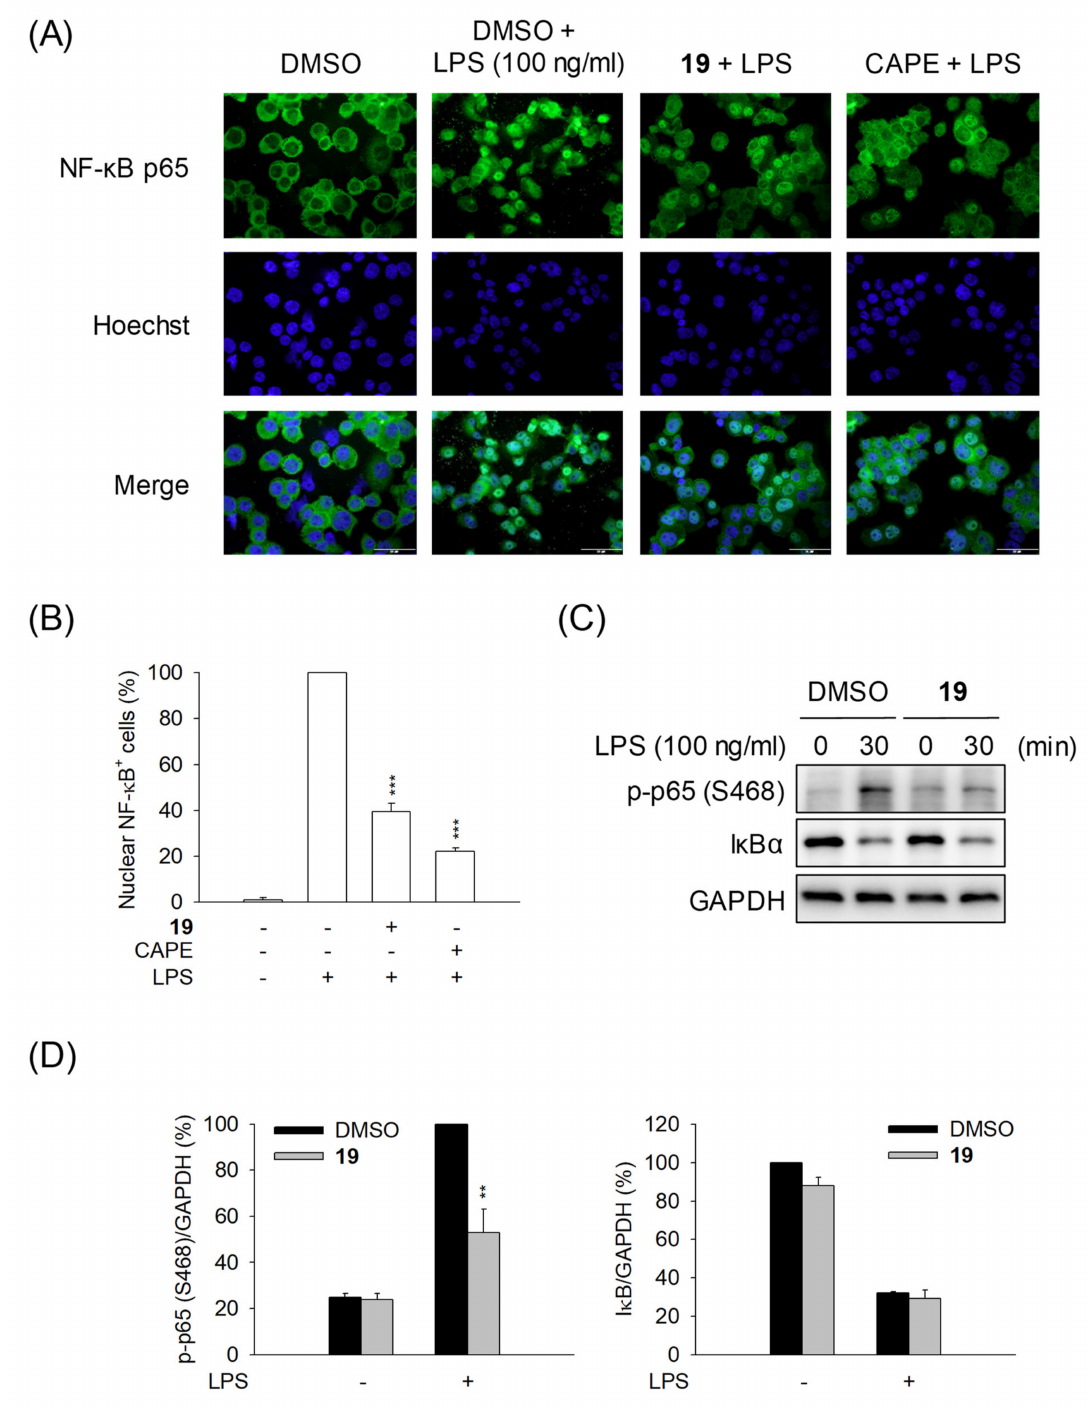
Figure 4. Compound 19 inhibits the LPS-induced nuclear translocation of NF- κ B p65 in differentiated THP − 1 (dTHP − 1) cells. The dTHP − 1 cells were incubated with DMSO (0.1%), 19 (7.5 µ M), or CAPE (10 µ M) in medium for 3 h and then stimulated with or without LPS (0.1 µ g/mL) for another 30 min. ( A ) Nuclear translocation of NF- κ B p65 (green) was determined by immunofluorescent microscopy. Hoechst (blue) was used for nuclei staining. ( B ) The nuclear NF- κ B p65-positive cells were quantified. ( C ) The levels of phospho-NF- κ B p65 (S468), I κ B, and GAPDH were determined by Western blot. ( D ) The normalized phospho-NF- κ B p65 (S468) and I κ B levels were quantified. All data are expressed as mean ± SEM ( n = 3); ** p < 0.01 and *** p < 0.001 compared with the DMSO + LPS